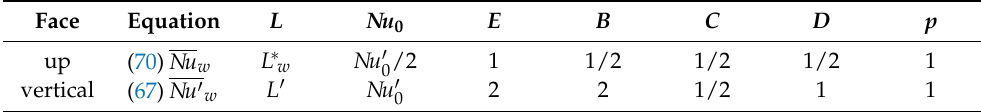
Table 11 lists the general derivation Formula (48) parameters for the side-wall flow topologies. Table 11. Side-walled plate